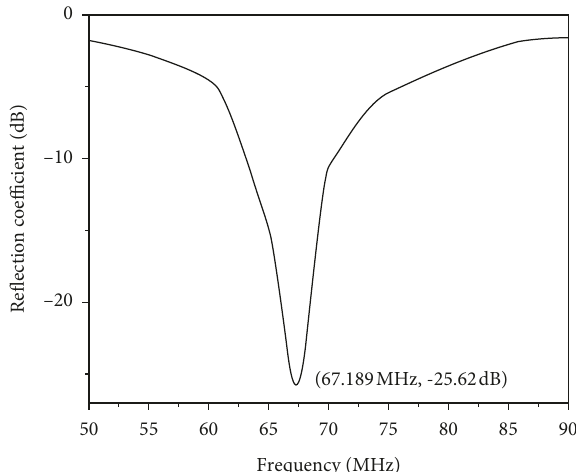
Figure 8: Resonant frequency and reflection coefficient of the midload whip antenna without shortening.